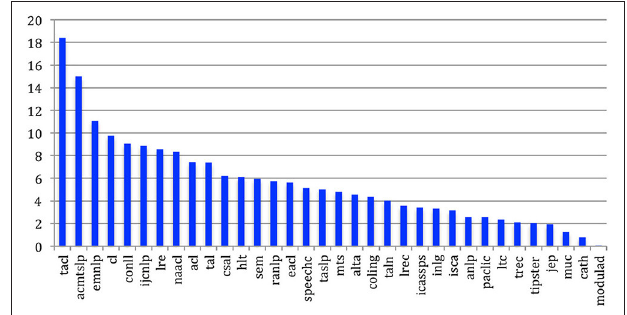
FIGURE 53 | Mean degree of papers citing papers in general for the 34 sources.